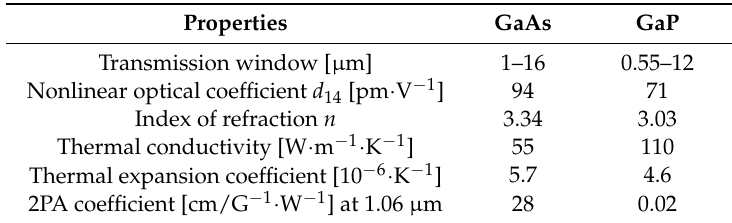
Table 1. A comparison between some optical and thermal properties of GaAs and GaP. 2PA = two-photon absorption.